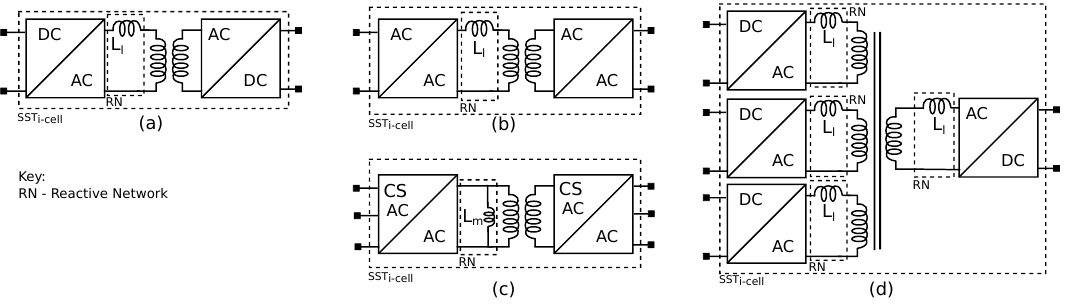
Figure 14. Coupled control: isolation stage (SST i-cell ) based on non-resonant stages: ( a ) dual active bridge [69,76] ( b ) AC/AC DAB for SST [72], ( c ) isolated AC/AC dyna C [74], ( d ) multiple active bridge (MAB): quad active bridge (QAB) [76].